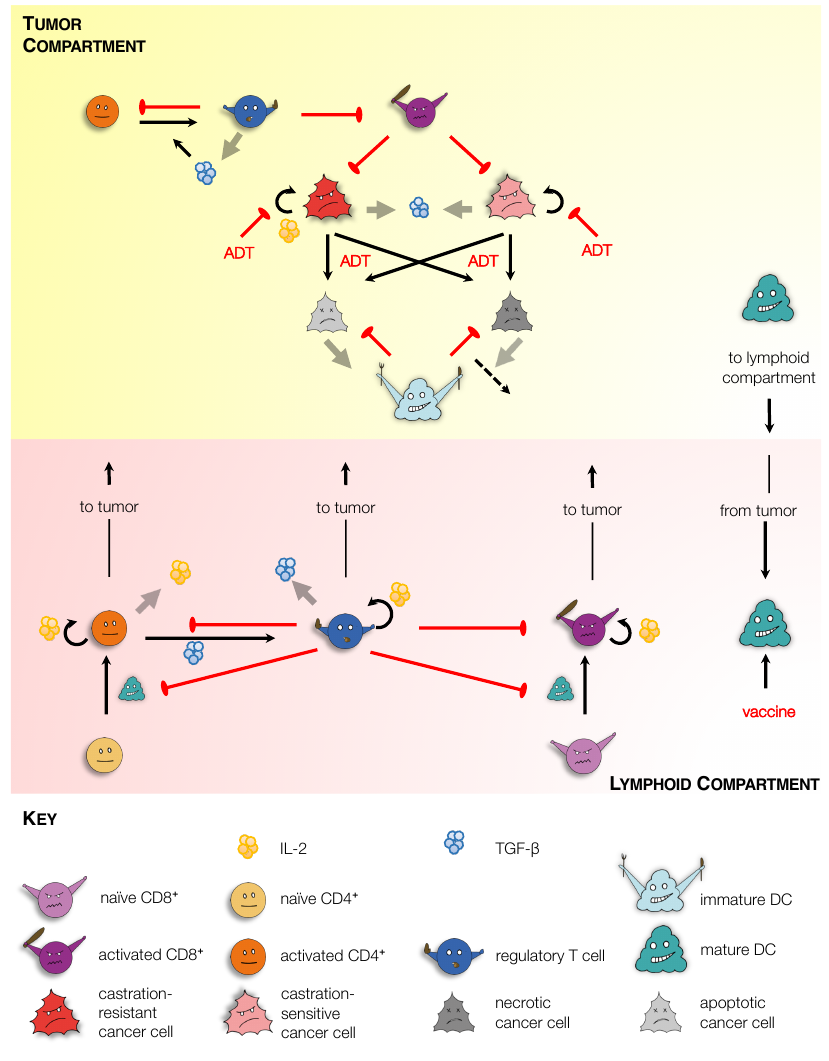
Figure 1. Schematic showing interactions between model variables, and their transport between the tumor and lymphoid